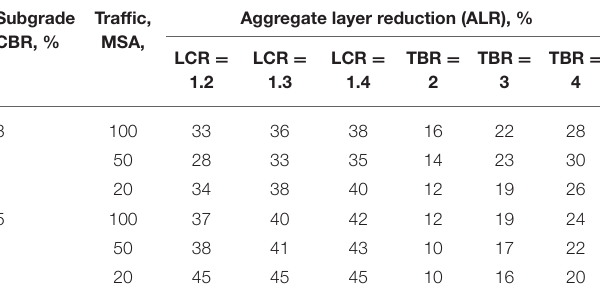
TABLE 2 | Aggregate layer reduction for selected subgrade CBR, traffic, LCR, and TBR values.